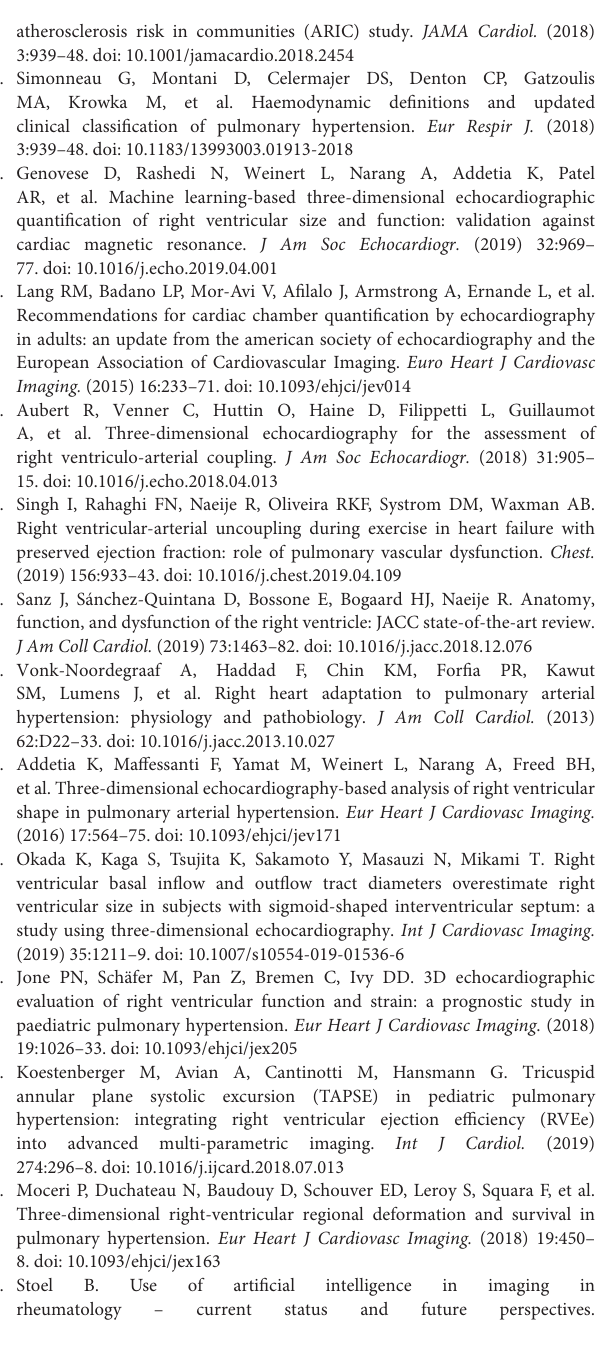
Supplemental Figure 1 | Example of machine learning-based 3D RVEF analysis using QLAB 13.0 software. End-diastolic and systolic verification and editing of endocardial RV borders, from which RVEDV, RVESV, and RVEF were